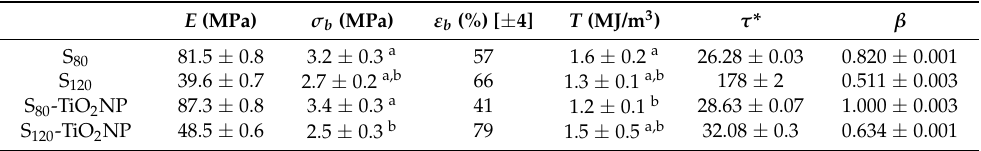
a,b Values with the same letters are not significantly different ( p > 0.05).